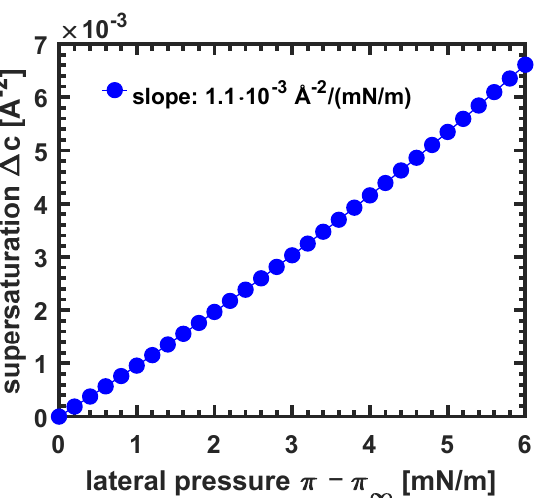
Figure A1. Supersaturation ∆ c in dependence of ∆ π = π − π c , the lateral pressure above the LE/LC phase transition at equilibrium conditions, of erucic acid of Figure 1.